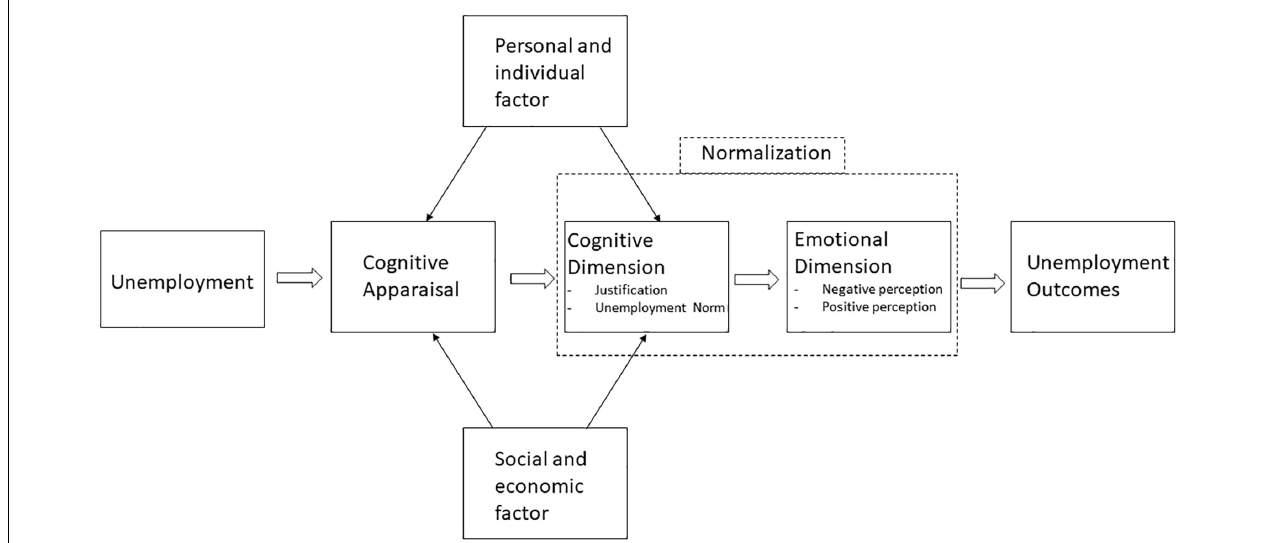
FIGURE 2 | Consideration of normalization as a coping